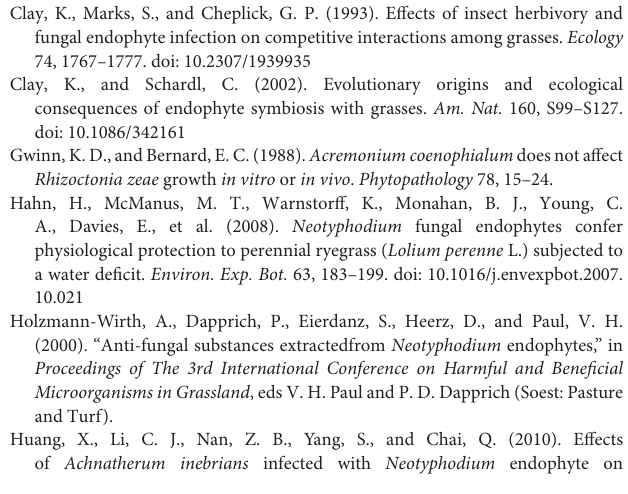
concentration from A. inebrians / E. gansuensis ( N. gansuense